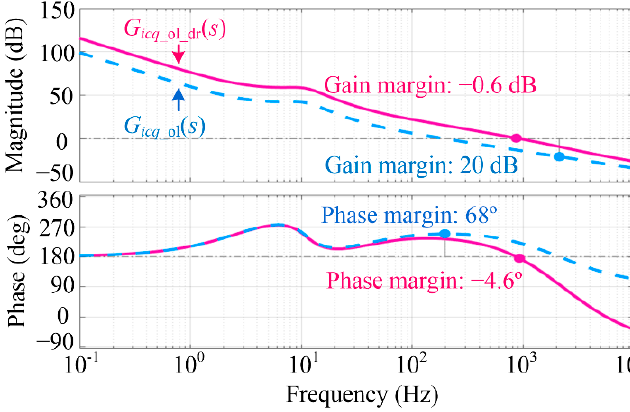
Figure 10. Bode plots of G icq _ol ( s ) and G icq _ol_dr ( s ). The magnitudes of the two transfer functions G icq_icq dr ( s ) and G vcq_icq dr ( s ) are both proportionally related to the droop coefficient K vq . In addition, according to (20) and (21), they are also positively related to the grid inductance L g . Figure 11 shows the Bode plots of G icq_icq dr ( s ) and G vcq_icq dr ( s ) with various K vq and L g . In Figure 11a, K vq is swept from